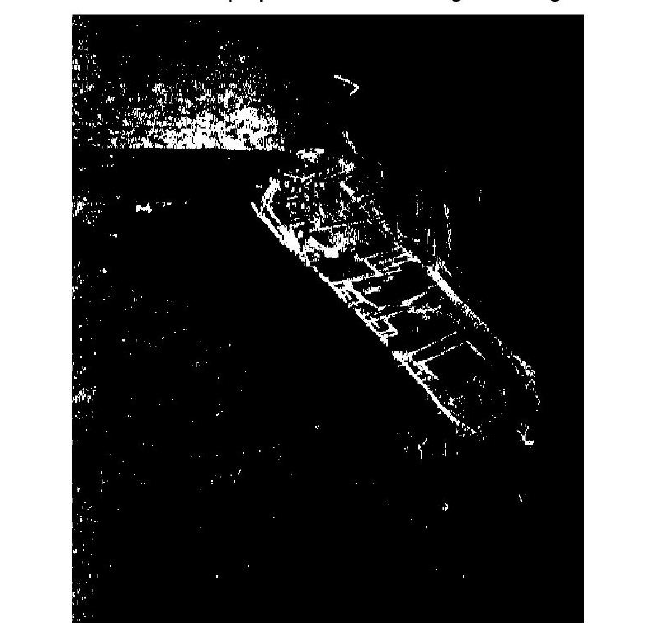
Figure 17. Data-smoothing achieved by